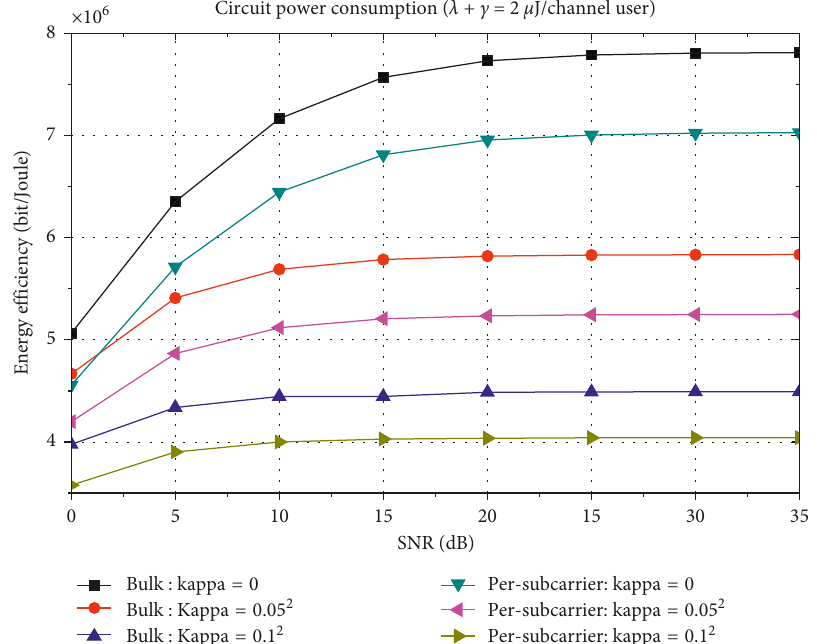
Figure 5: Energy efficiency of the massive MIMO-OFDM channel versus the SNR for per-subcarrier selection and bulk antenna selection techniques using various hardware impairments (kappa